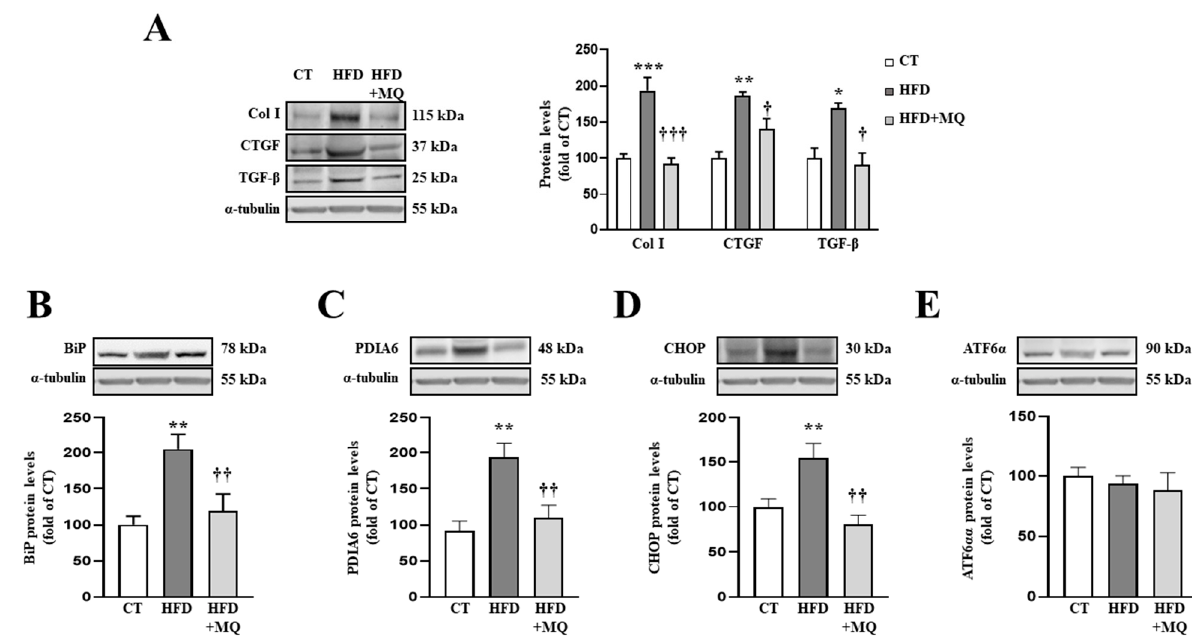
Figure 1. Mitochondrial oxidative stress mediates the increase in extracellular matrix proteins and endoplasmic reticulum stress at cardiac level. Protein levels of ( A ) collagen type I (Col I), connective tissue growth factor (CTGF) and transforming growth factor-beta (TGF- β ); ( B ) immunoglobulin binding protein (BiP); ( C ) protein disulfide isomerase family A member 6 (PDIA6); ( D ) CCAAT-enhancer-binding protein homologous protein (CHOP); ( E ) activating transcription factor 6-alpha (ATF6 α ) in heart tissue from control rats fed a normal chow (CT) and rats fed a high-fat diet (HFD) treated with vehicle or with the mitochondrial antioxidant MitoQ (MQ; 200 µ M). Bars graphs represent the mean ± SEM of 6–8 animals normalized for α -tubulin. * p < 0.05, ** p < 0.01, *** p < 0.001 vs. control group. † p < 0.05, †† p < 0.01, ††† p < 0.001 vs. HFD group.